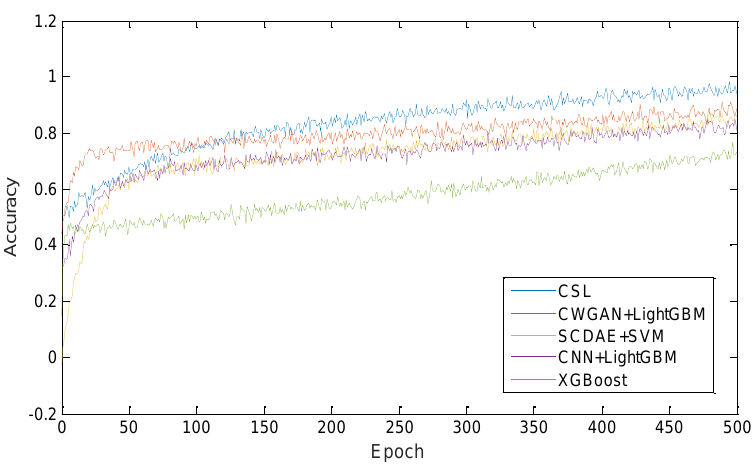
Figure 9. Comparison of ROC curves of each model.